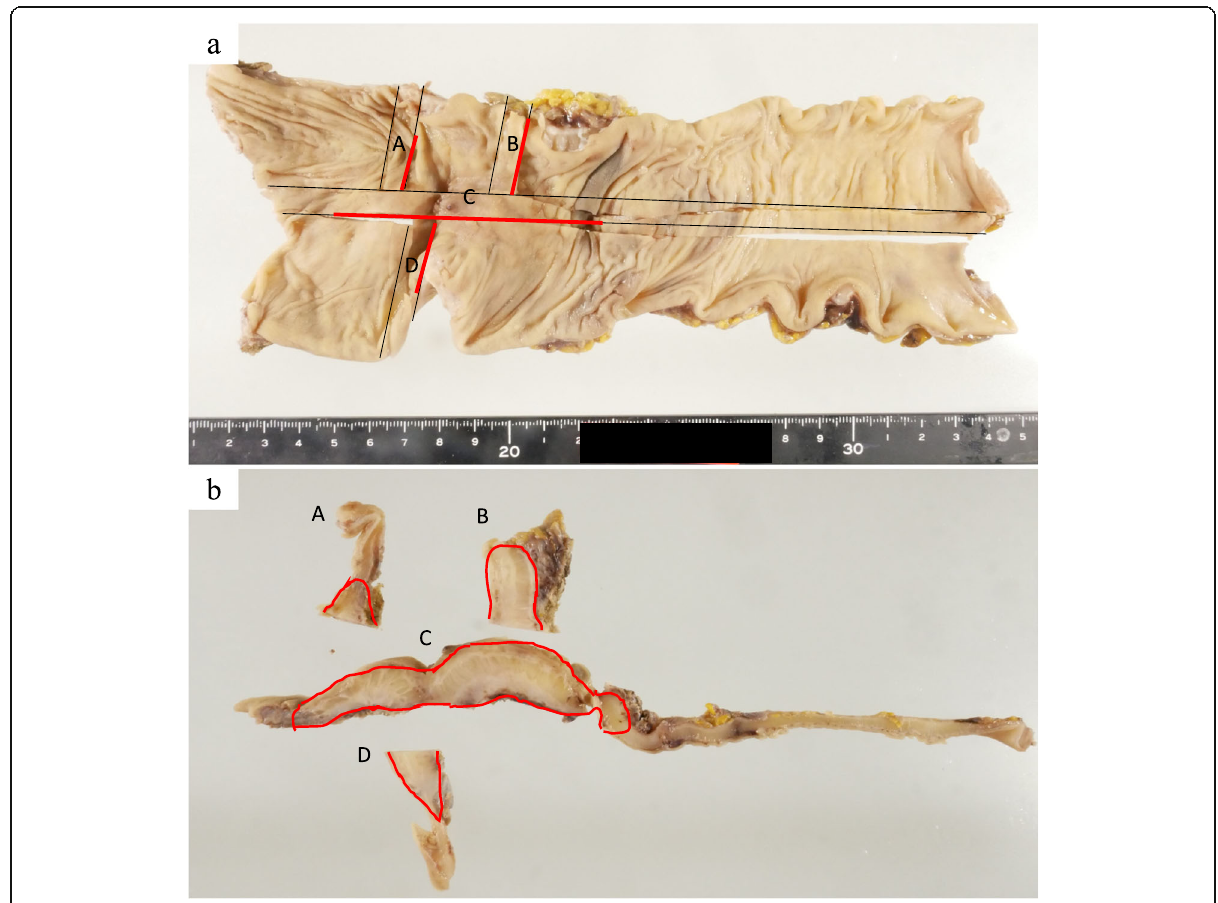
Fig. 4 Resected specimen. The resected specimen contained an approximately 10-cm submucosal tumor-like lesion. Endometriosis showed within the red line and